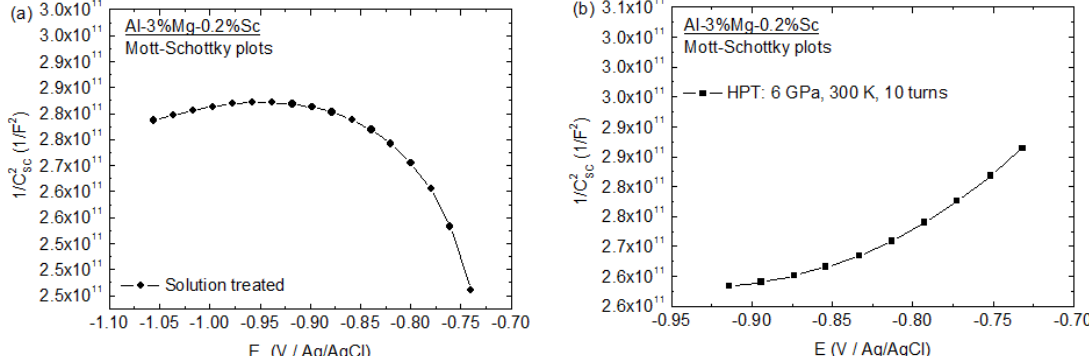
Figure 7. Mott-Schottky plots for (a) the solution treated and (b) the HPT-processed alloy in 3.5 wt./v. NaCl solution at 1000 Hz